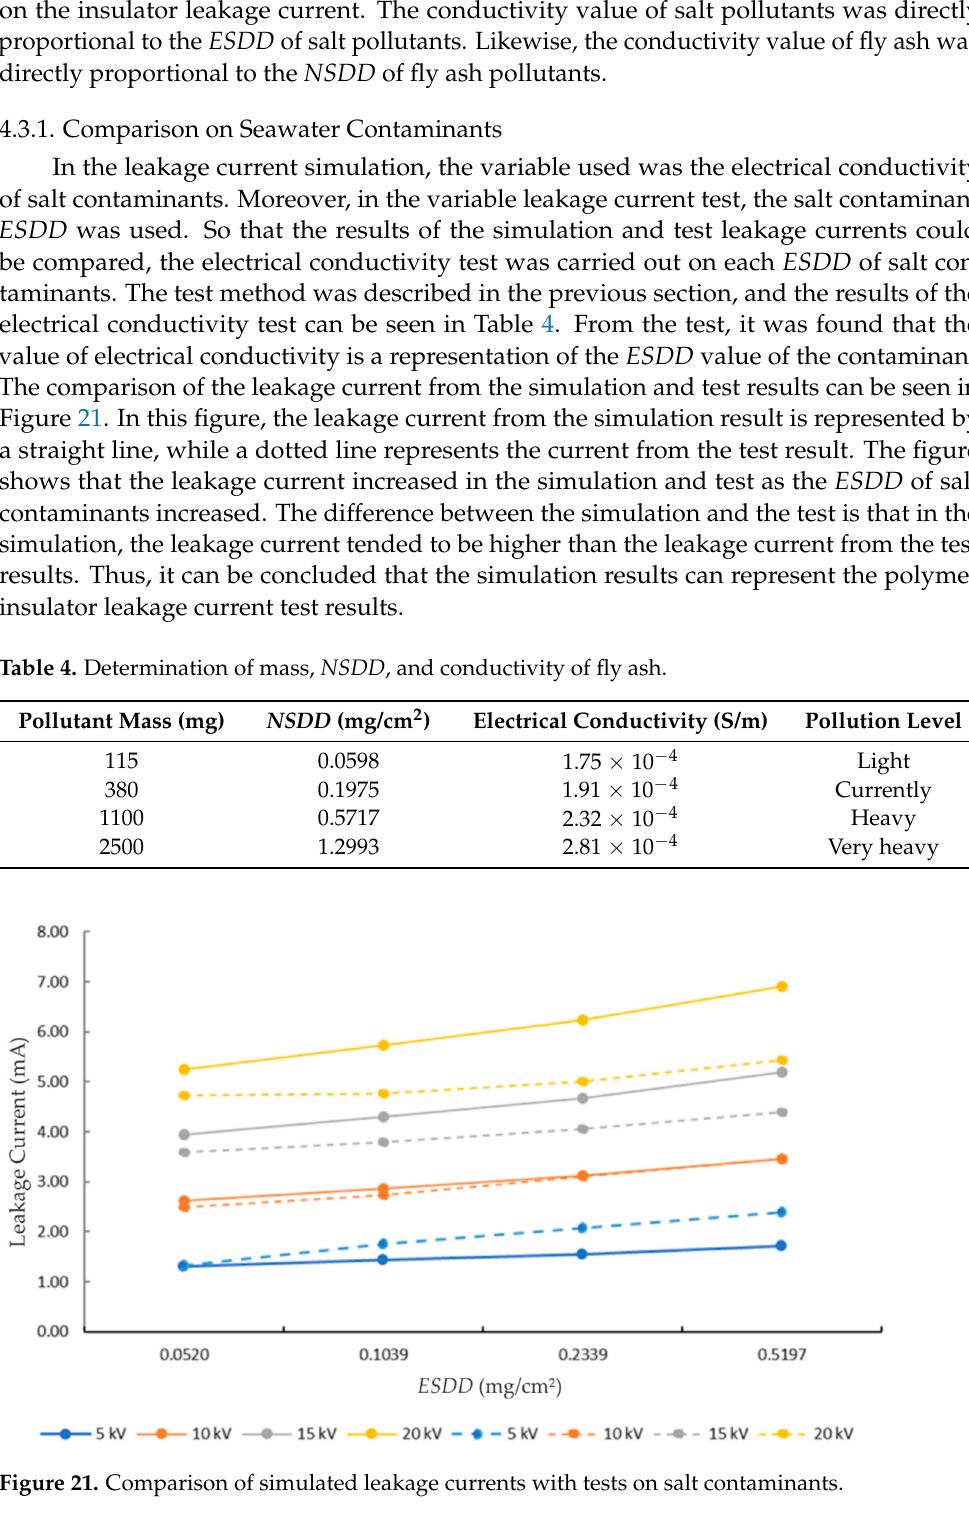
Figure 21. Comparison of simulated leakage currents with tests on salt